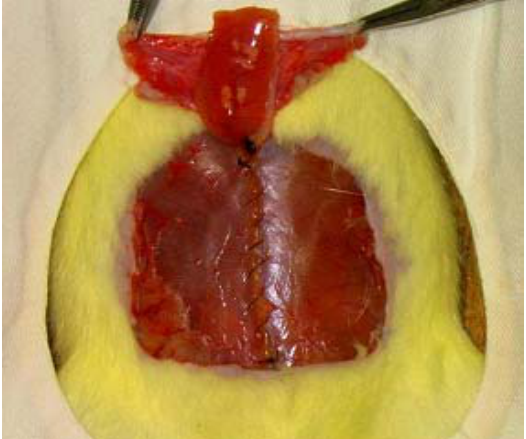
FIGURE 6: The incision completed by sectioning of the muscular pedicle to be discarded (in this case, caudal) with subsequent flap release.